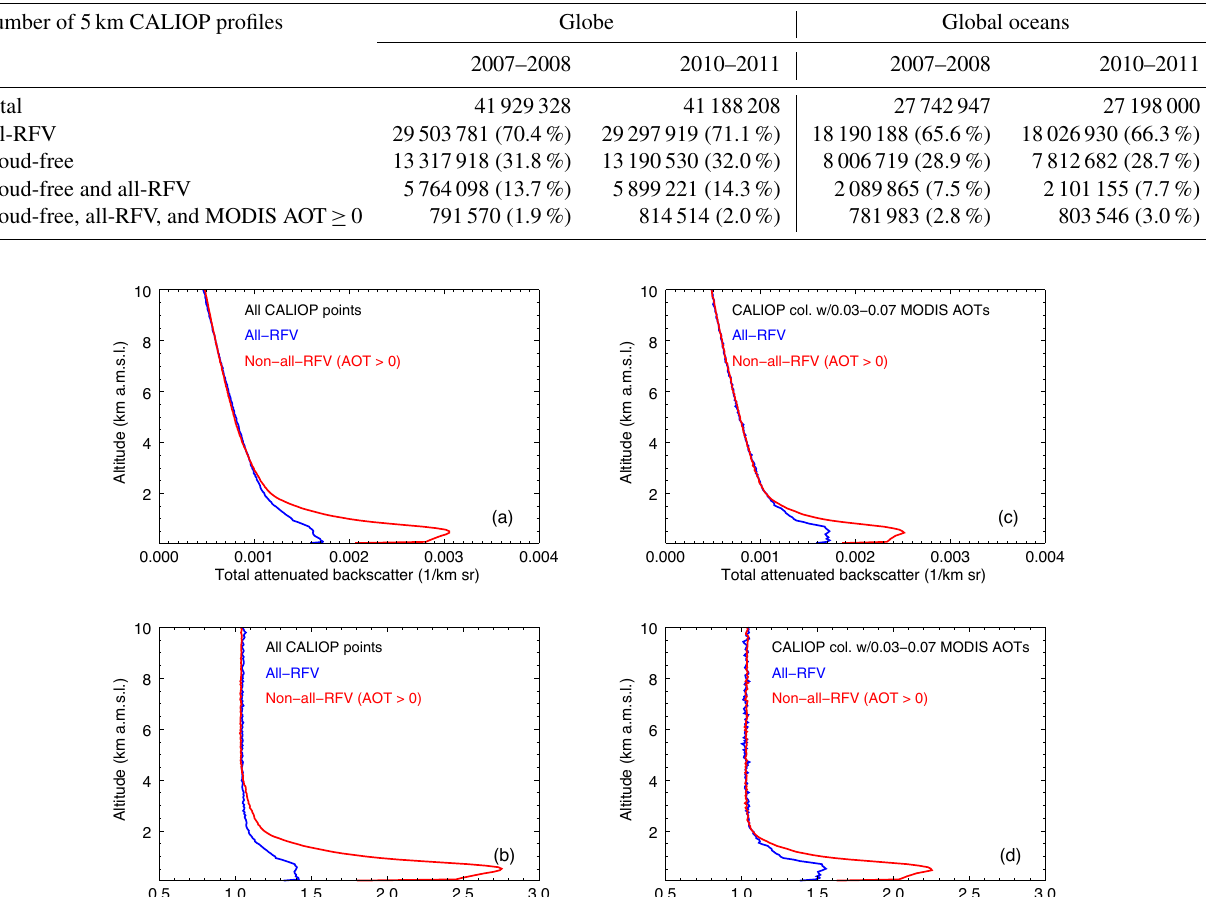
Table 1. Statistical summary of the results for this study for the 2007–2008 and 2010–2011 periods, both globally and for global oceans only. The values in parentheses represent the percentages of each category relative to the entire CALIOP aerosol profile archive for each respective period.